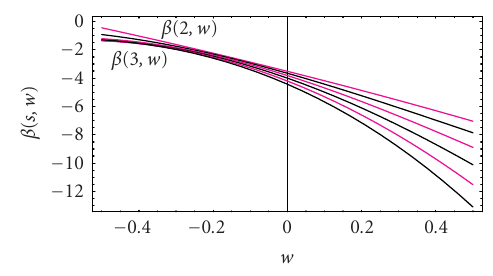
Figure 4.4. The curve of β ( s , w ), 2 ≤ s ≤ 3, − 0 . 5 ≤ w ≤ 0 . 5, q = 11 / 10